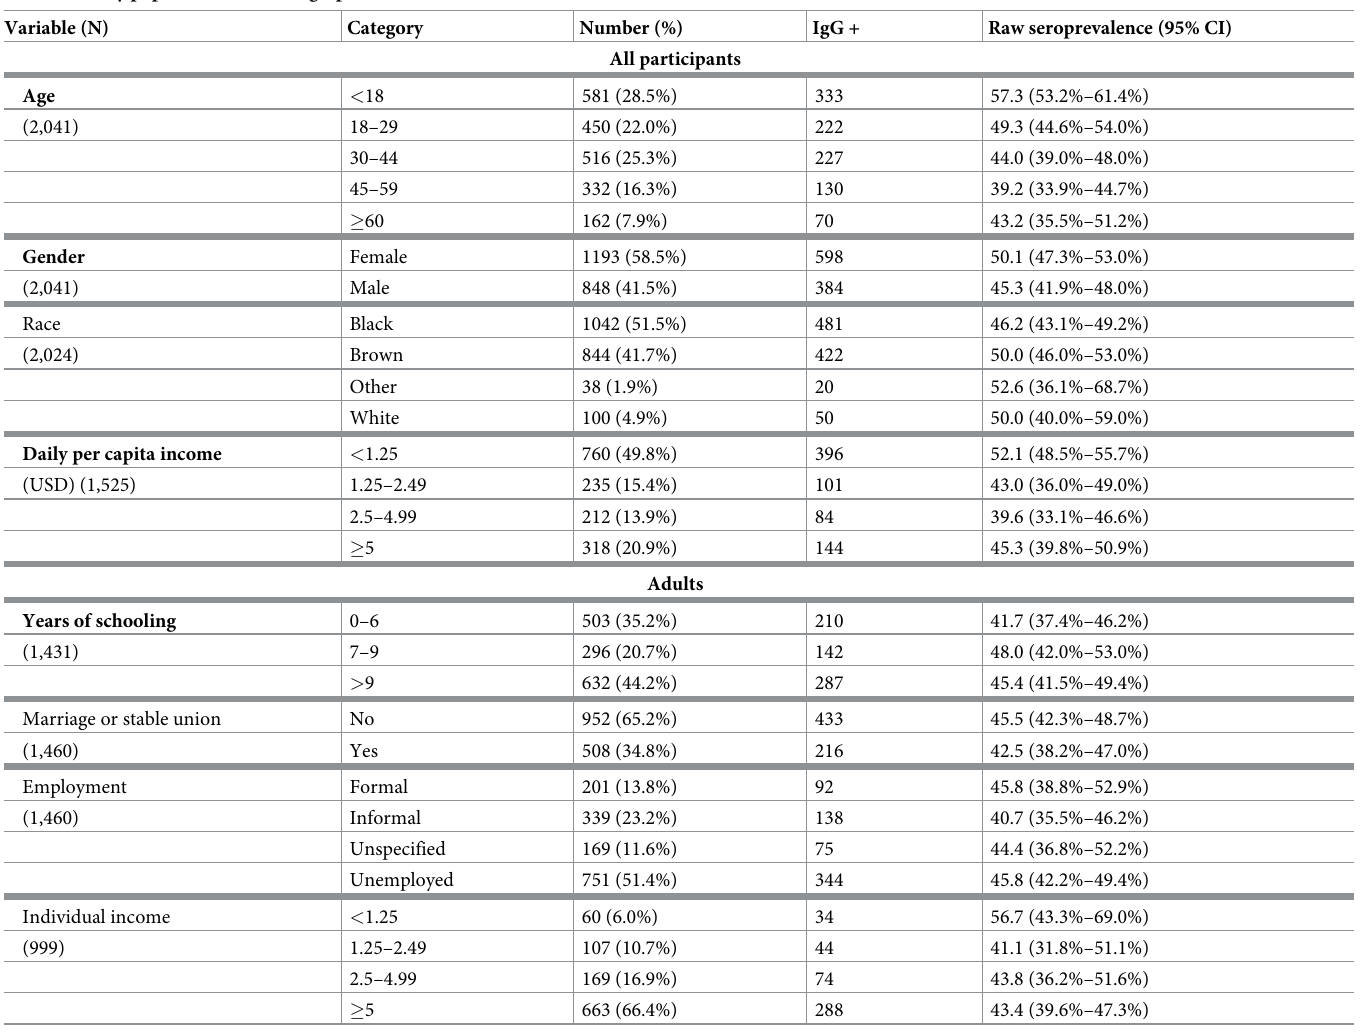
Table 1. Study population and demographic